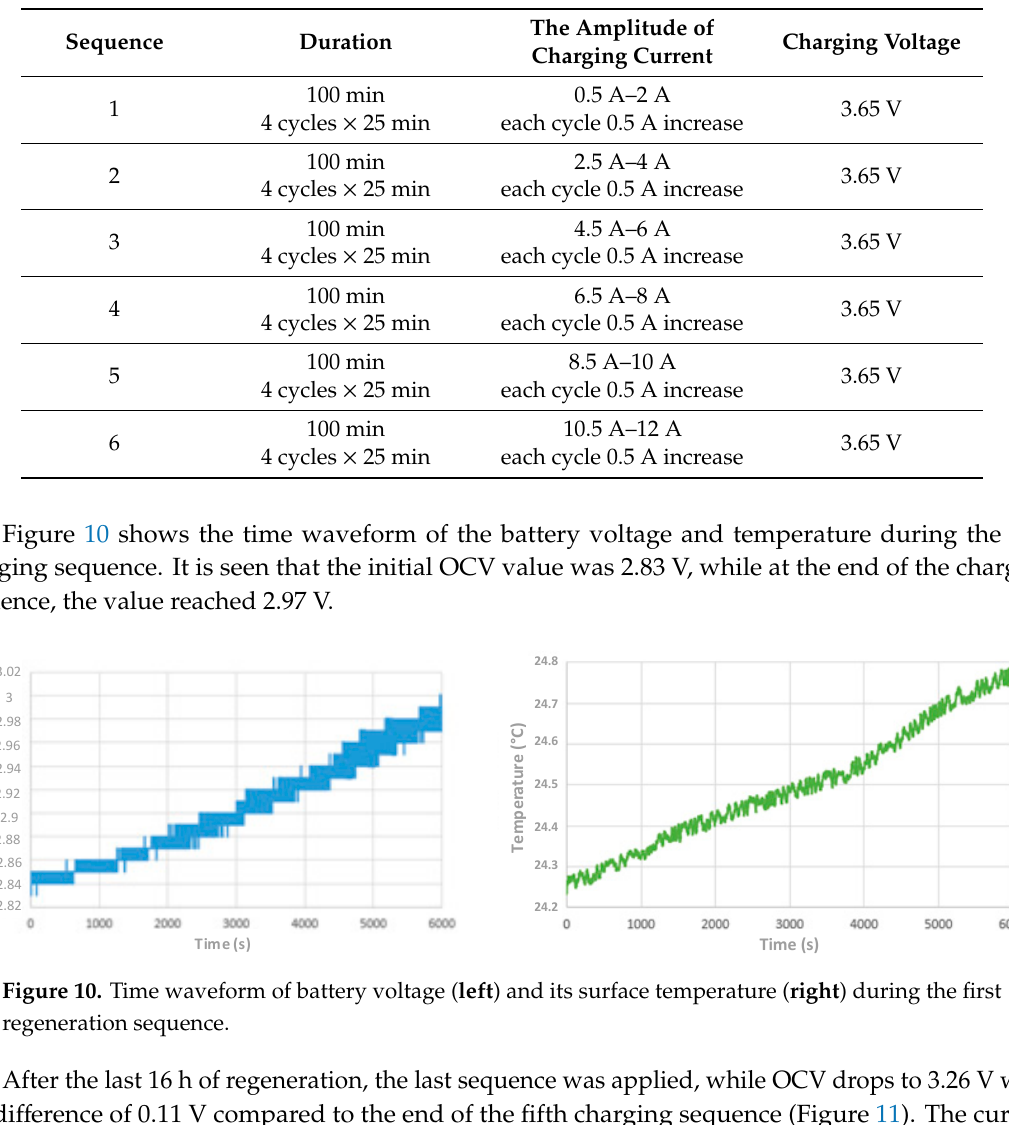
Table 2. The setting of individual sequences of regeneration algorithm for short-circuited cell.